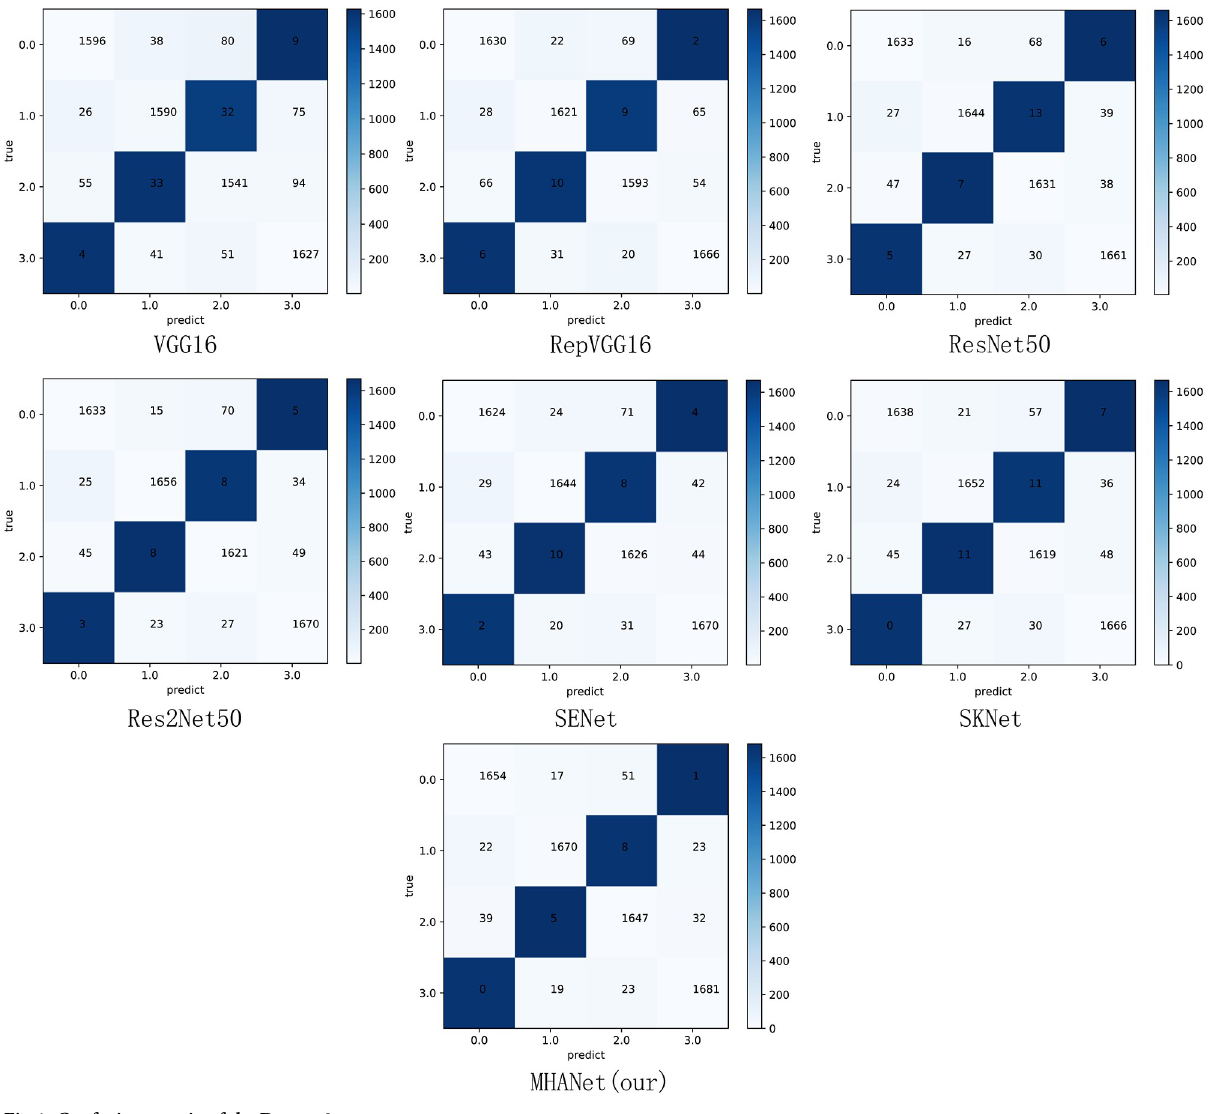
Fig 4. Confusion matrix of the